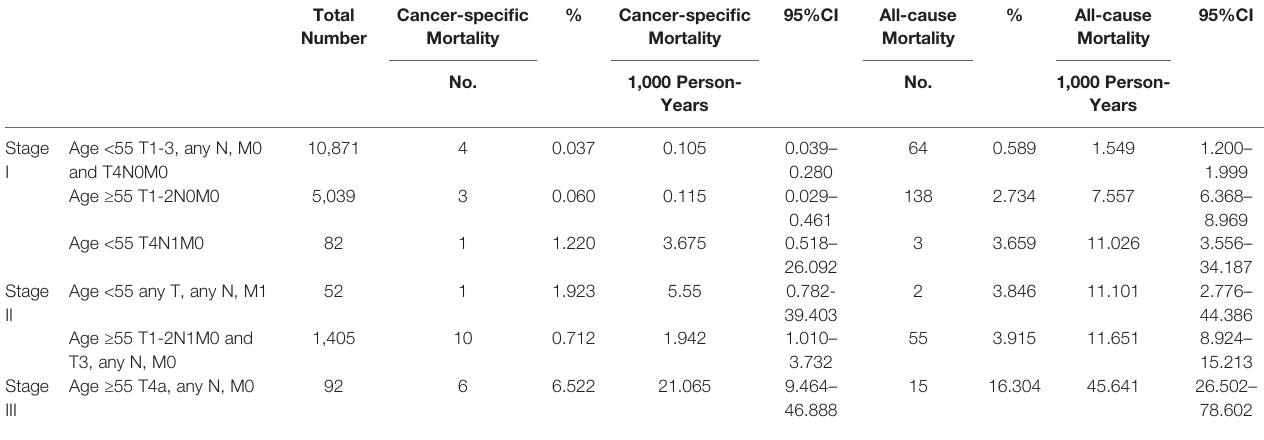
TABLE 4 | Measures of cancer-speci fi c mortality and all-cause mortality of FVPTC.